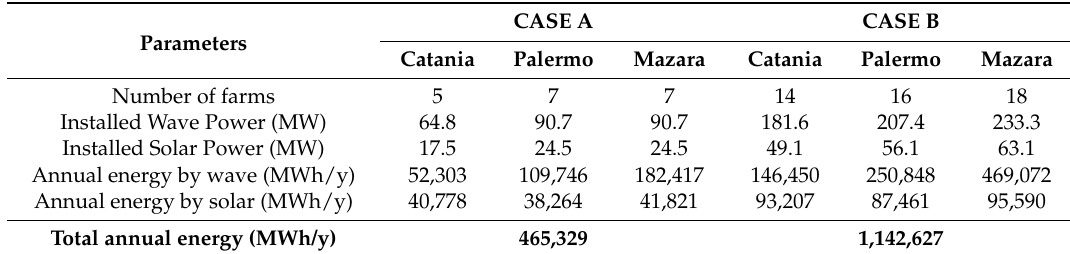
Table 5. Comparison between the two different